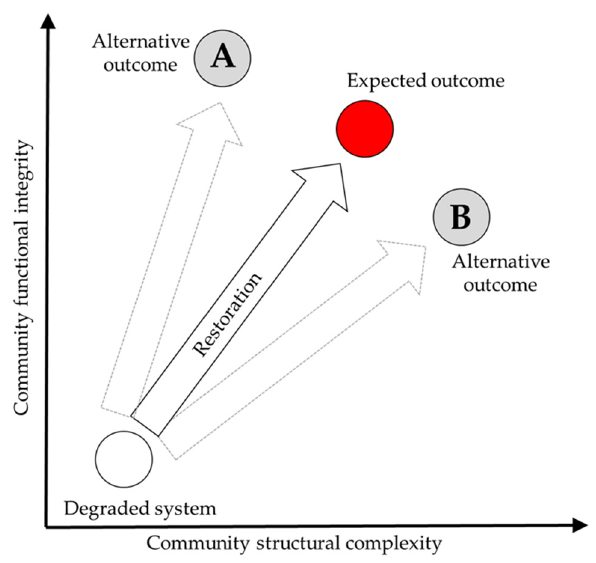
Figure 1. A general model of ecological restoration, where the objective is to increase structural and/or functional complexity.